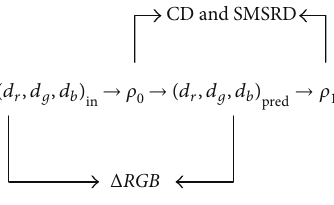
Figure 5: Computing errors. Table 2: The difference between the measured values and predicted values of the inverse